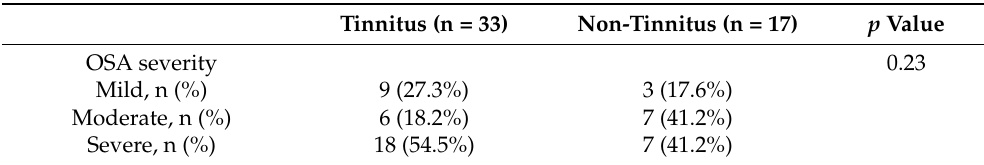
Table 2. Comparisons of OSA severity between tinnitus and non-tinnitus